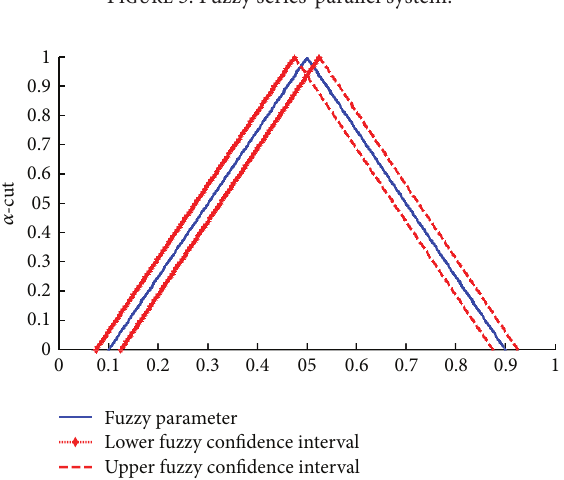
Figure 4: Two-sized 100(1 − 𝛾) % confidence intervals for fuzzy